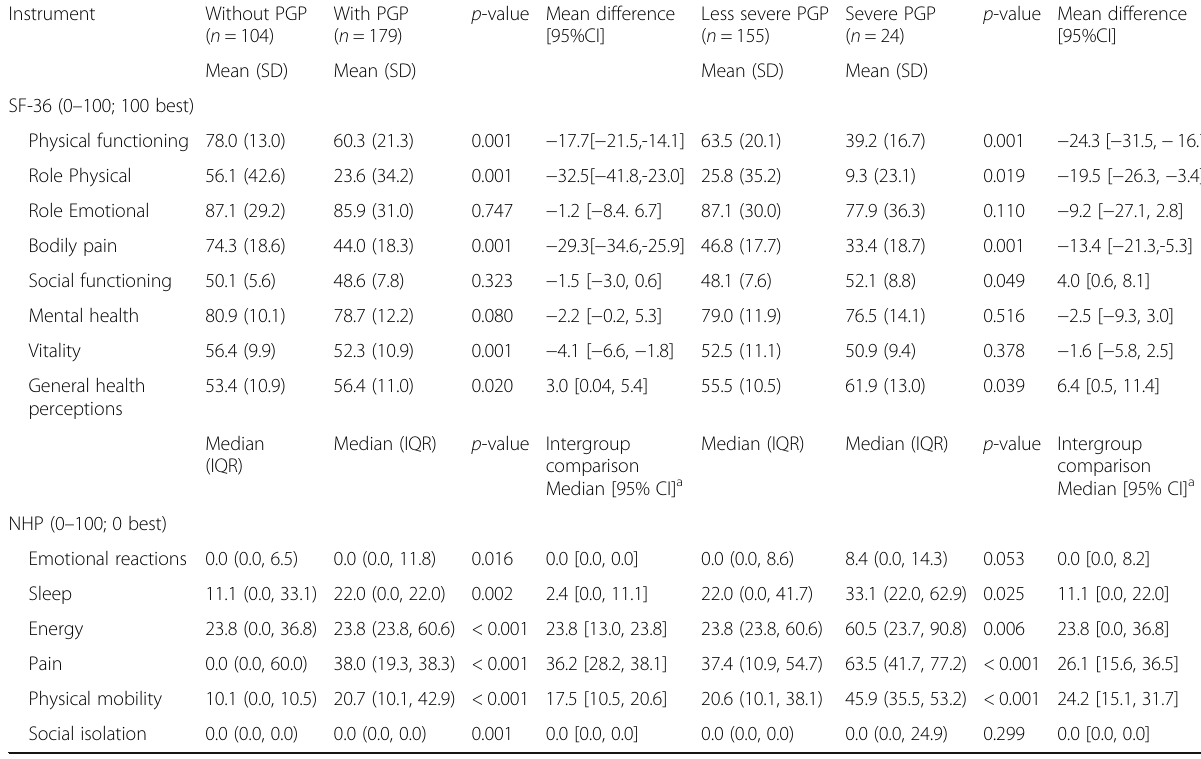
Table 3 Differences between groups of women with and without self-reported PGP, and women with severe and less severe PGP on the SF-36 and NHP, using t-tests, Mann-Whitney U tests and Hodges-Lehman estimate of difference in the median of the 2 groups Instrument